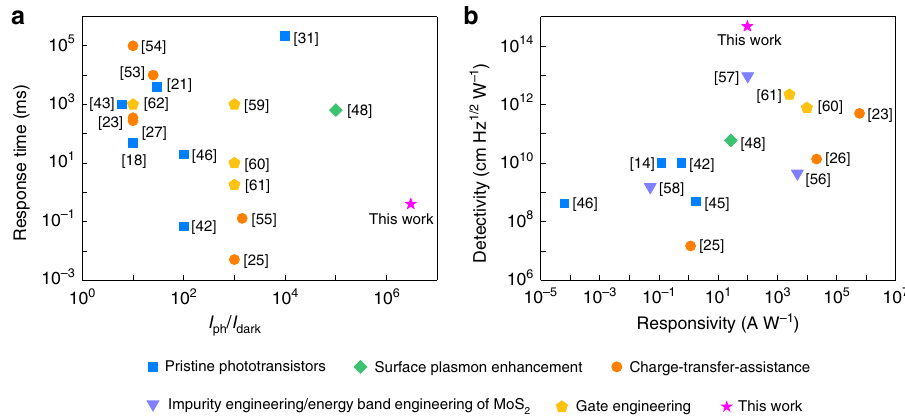
Fig. 5 Optimization strategy and performance summary of reported MoS 2 phototransistors. Optoelectronic properties ( a response time and the ratio of photocurrent to dark current. b responsivity and detectivity) of NC MoS 2 phototransistors based on ferroelectric HZO gate dielectric engineering in